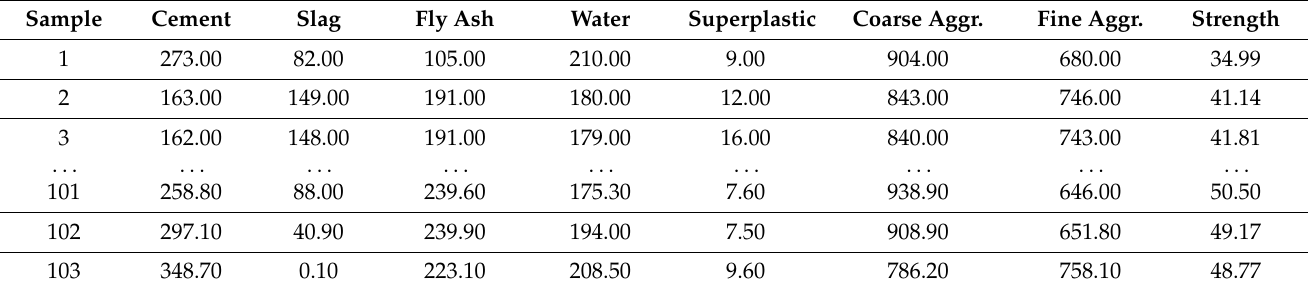
Table 2. Part of the data: here are the first three samples and the last three